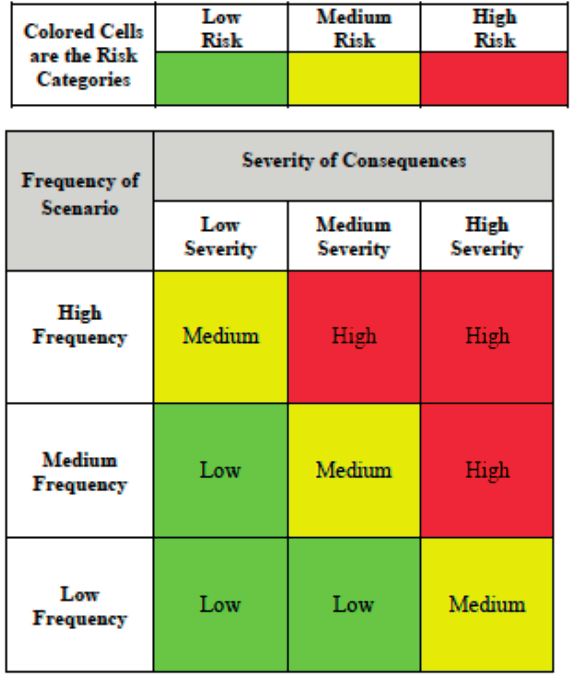
Figure 1. Generic risk assessment